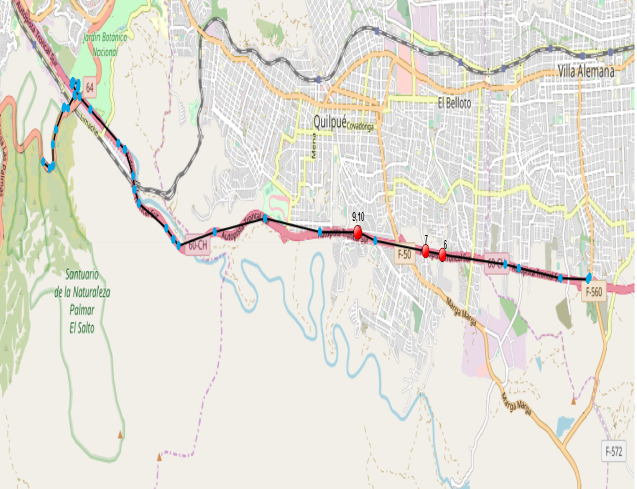
Figure 9. Example of a normal trajectory according to human expert detected as outlier by neural network. The light blue points indicate GPS measurements of the complete trajectory, while the red points indicate the points with the highest reconstruction error according to the neural network. See detail in